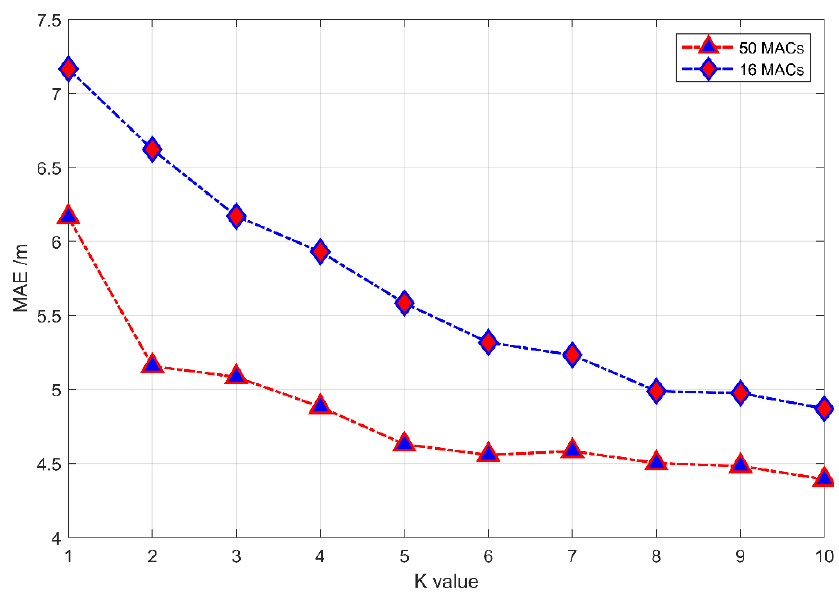
Figure 8. MAEs of 16 and 50 MACs under different K values.